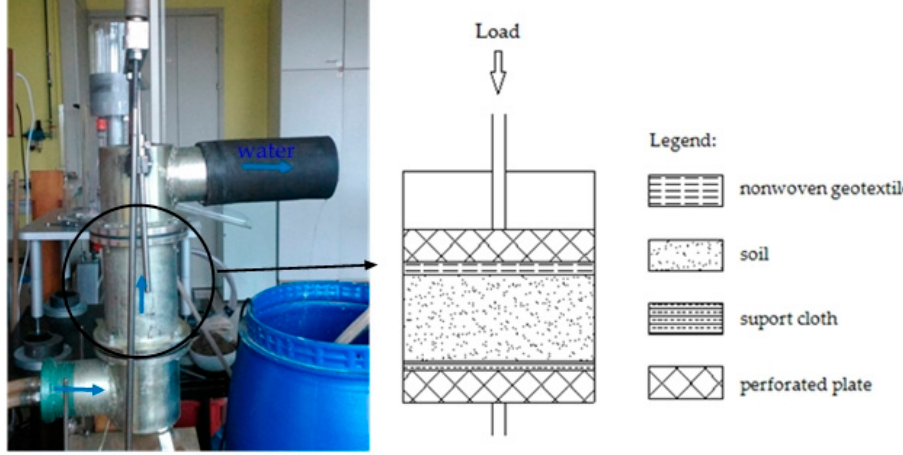
Figure 8. Laboratory equipment for artificial clogging.